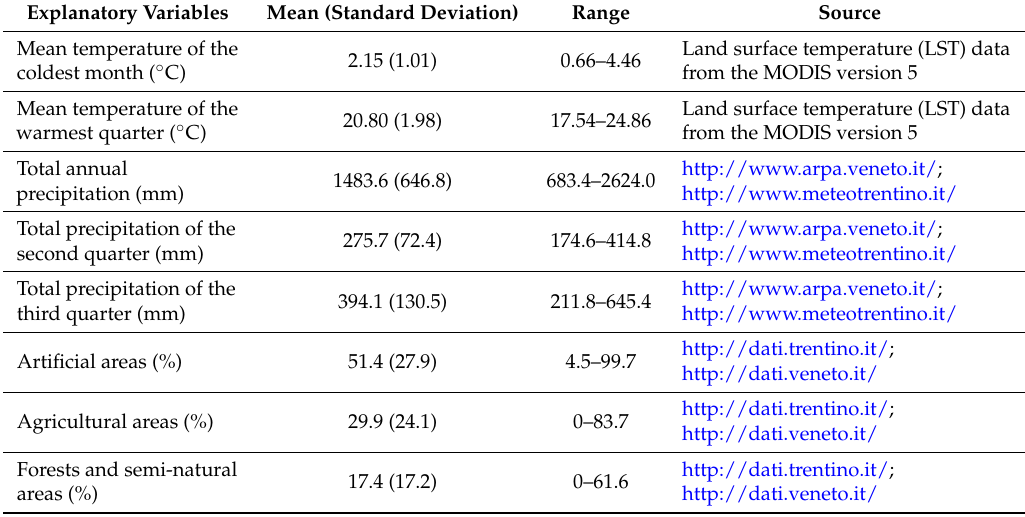
Table 1. Mean (standard deviation) and range values of the meteorological and land use variables used for abundance model selection (period